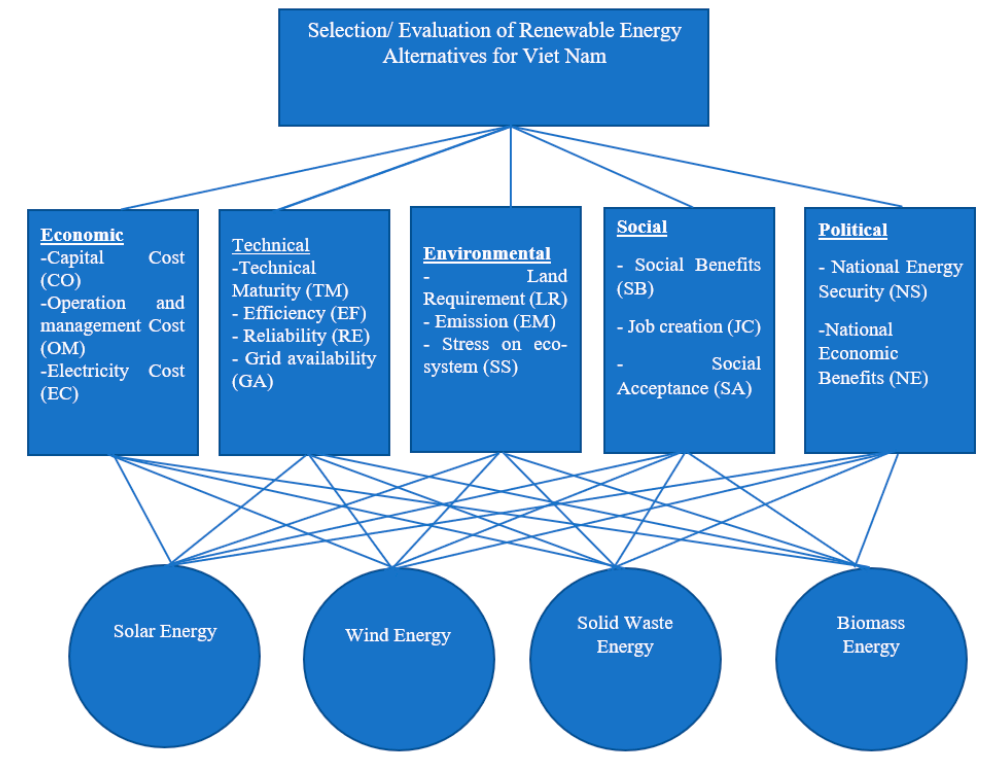
Figure 4. The hierarchical structure creation for the decision problem. Table 4. Crisp weight from Grey-AHP.